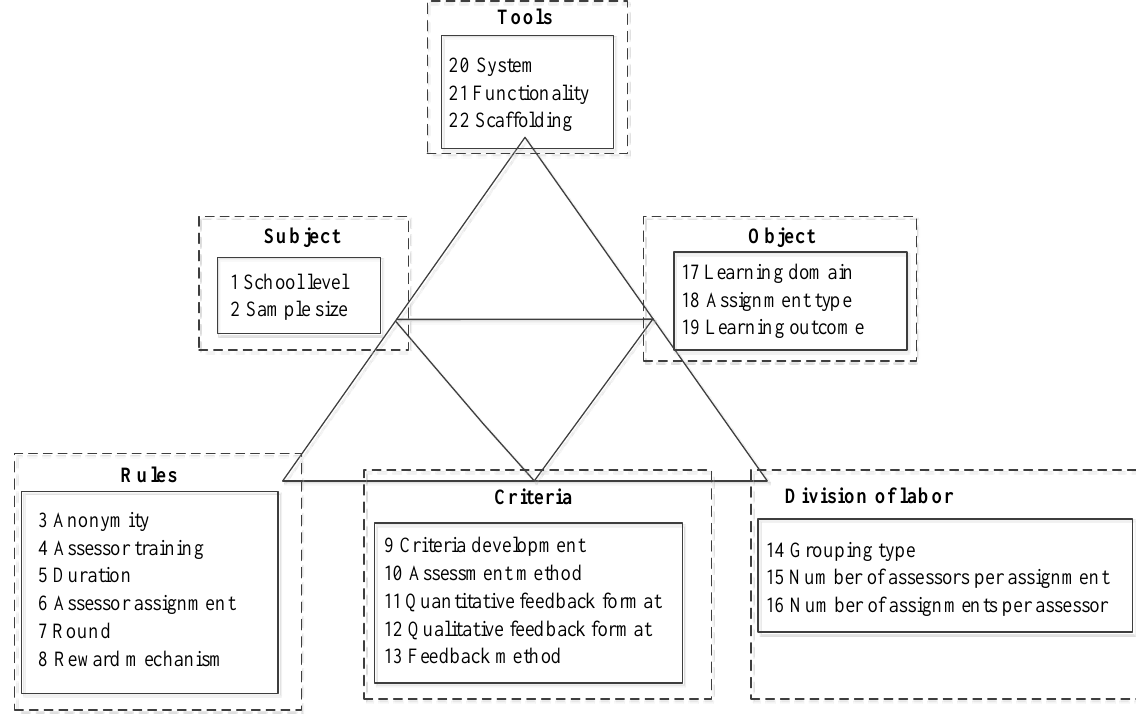
Figure 2 . The analysis framework for peer assessment research based on activity theory. Adapted from “Activity theory and individual and social transformation,” by Y. Engeström, in Y. Engeström, R. Miettinen, & R.-L. Punamäki (Eds.), Perspectives on activity theory (pp. 19–38), 1999, New York, NY: Cambridge University Press. Copyright 1999 by Cambridge University Press. Adapted with permission.